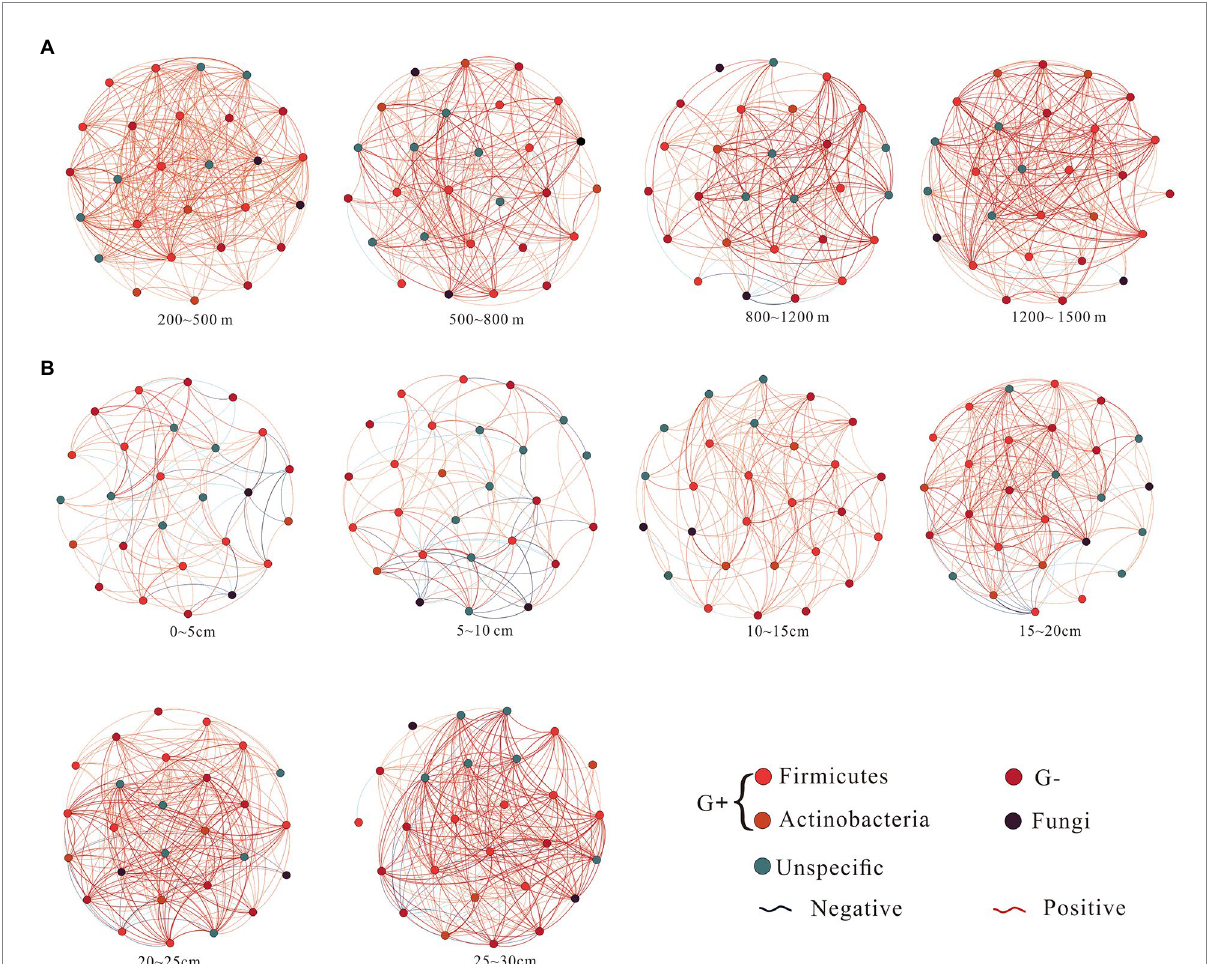
FIGURE 3 Microbial co-occurrence networks along the altitudinal (A) and depth (B) gradient on Changbai Mountain, China. The networks of co-occurring microbial biomarkers were determined based on Pearson correlation analysis. The node suggests the individual microbial biomarker based on the phospholipid fatty acid. The co-occurrence network nodes are colored by microbial groups. Blue edges indicate negative relationships between two individual nodes, while red edges suggest positive relationships. A connection stands for a strong correlation coefficient ( r ) >0.5. Each depth network was constructed from eight samples. Each altitudinal network was constructed from 12 samples.